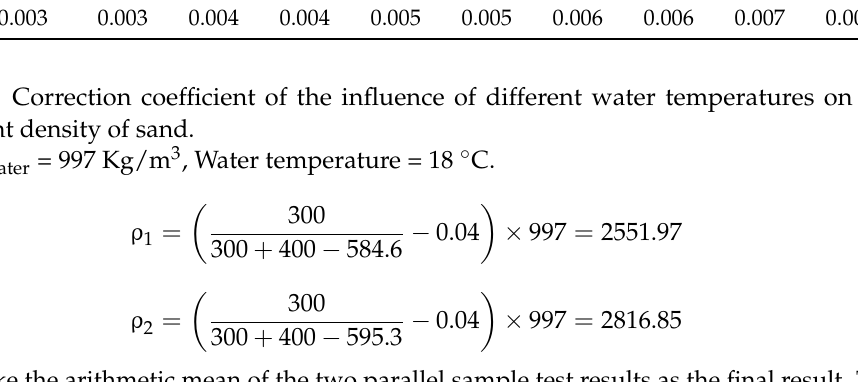
Table 3. Correction coefficient of the influence of different water temperatures.